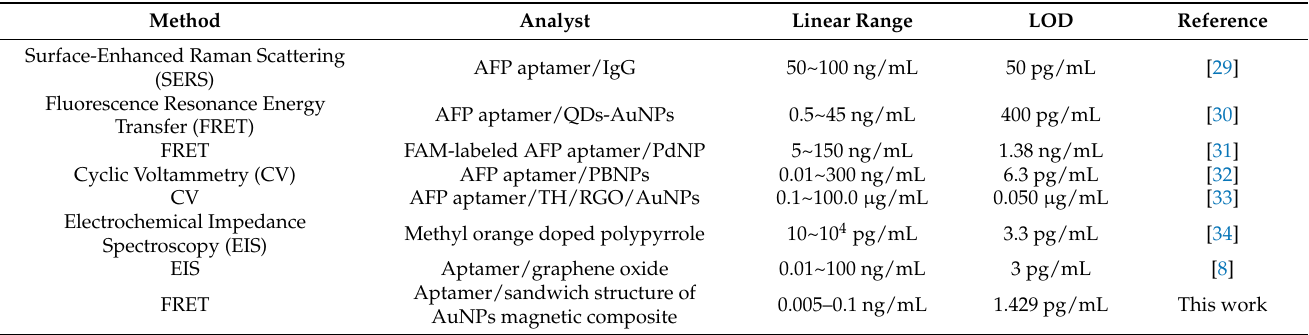
Figure 7. Fluorescence intensity ( A ) and F/F 0 -1 ( B ) changes induced by different concentrations of AFP. Table 1. Comparison of the AFP detection methods.